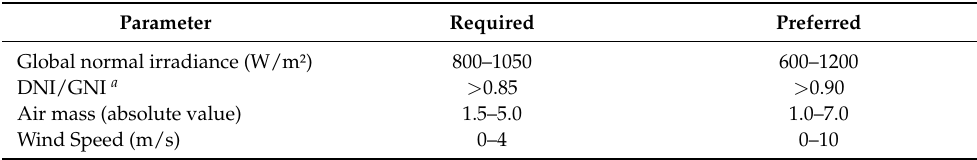
Table A1. Parameters required for qualifying a measurement as referring to a clear sky day [47]. Parameter